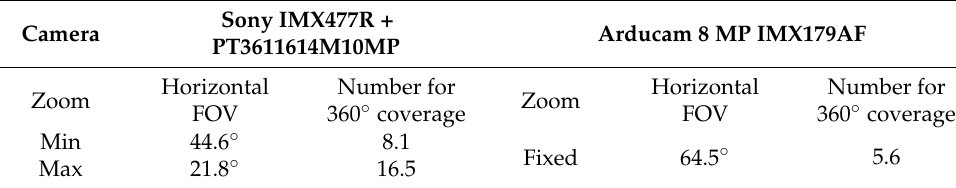
Table 1. The technical specifications of the applied